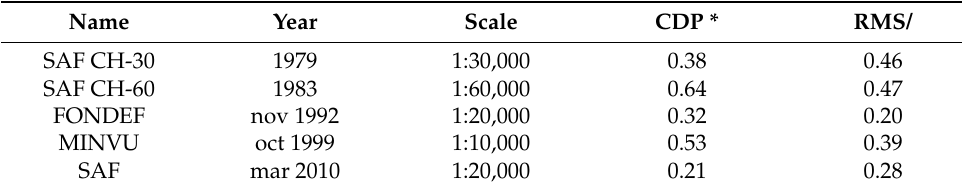
Table 1. Aerial photographs used in the determination of the planform changes of the shoreline and the mean squared error. In general, all of the errors were less than 1 m. Name